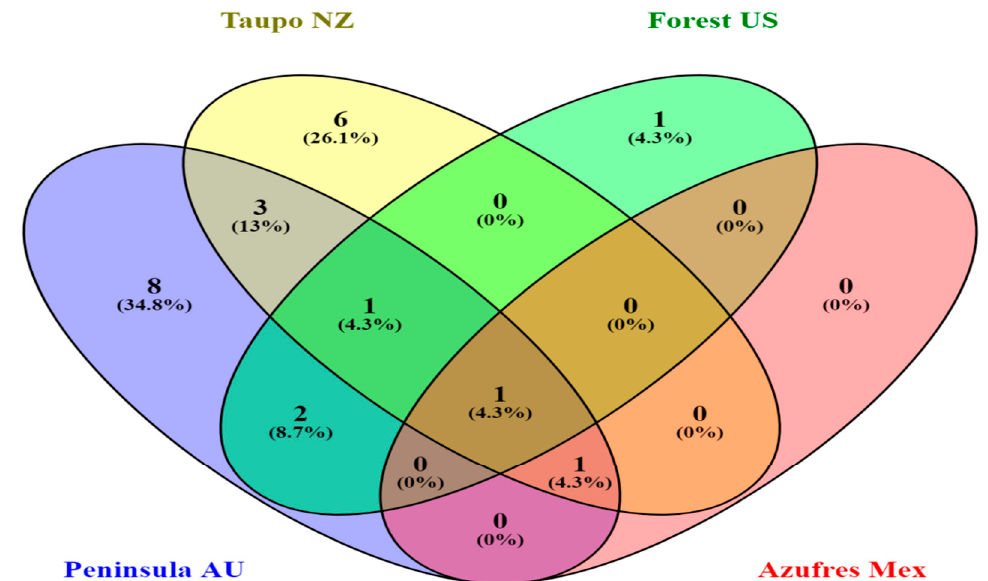
Figure 5. Percentage of Phyla in Peninsula hot springs Australia (borehole); Forest springs California, Taupo springs NZ and los Azufres, Mexico. Phylum common in the four hot springs is the Proteobacteria. Range of temperature in the four hot springs: 35 to 48 °C. The pH is different in each.